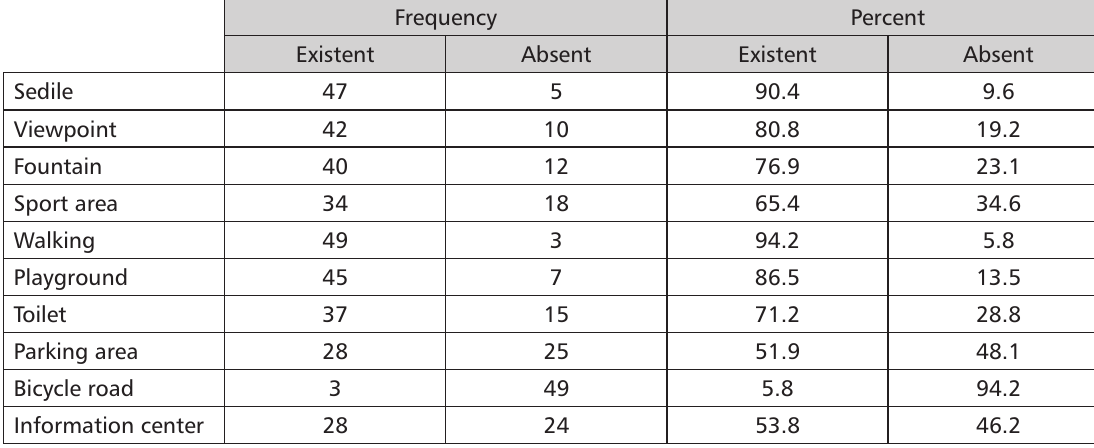
A Playground in Bartın Urban Forest Actually recreational facilities in urban